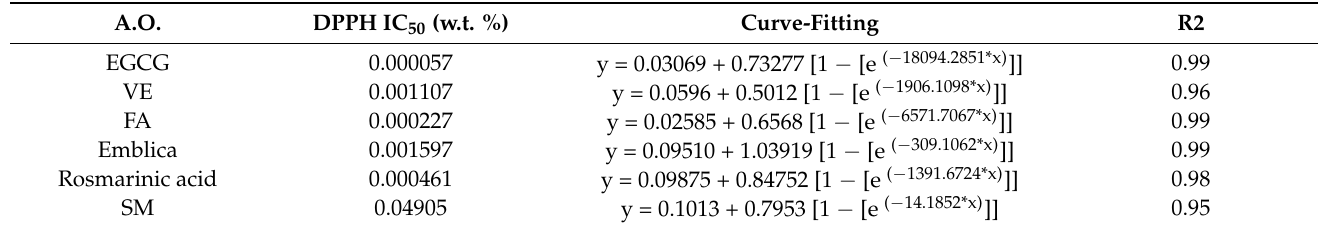
Table 3. DPPH IC 50 values for the respective AO and its curve fittings including r 2 (EGCG = Epigal- locatechin Gallate, VE = Alpha-Tocoperol/Vitamin E, FA= Ferulic acid, SM= Sodium